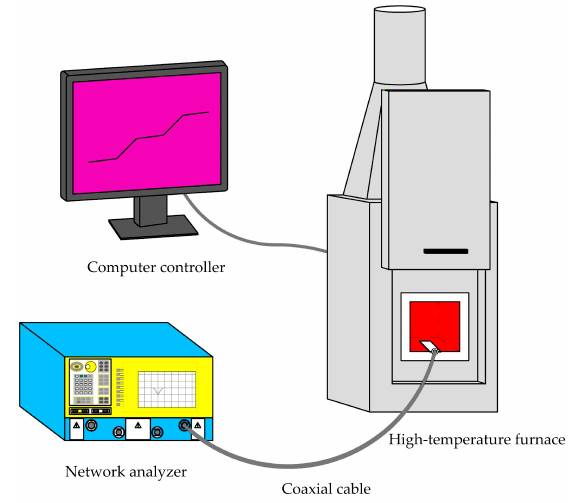
Figure 8. Illustration of the high-temperature testing system.